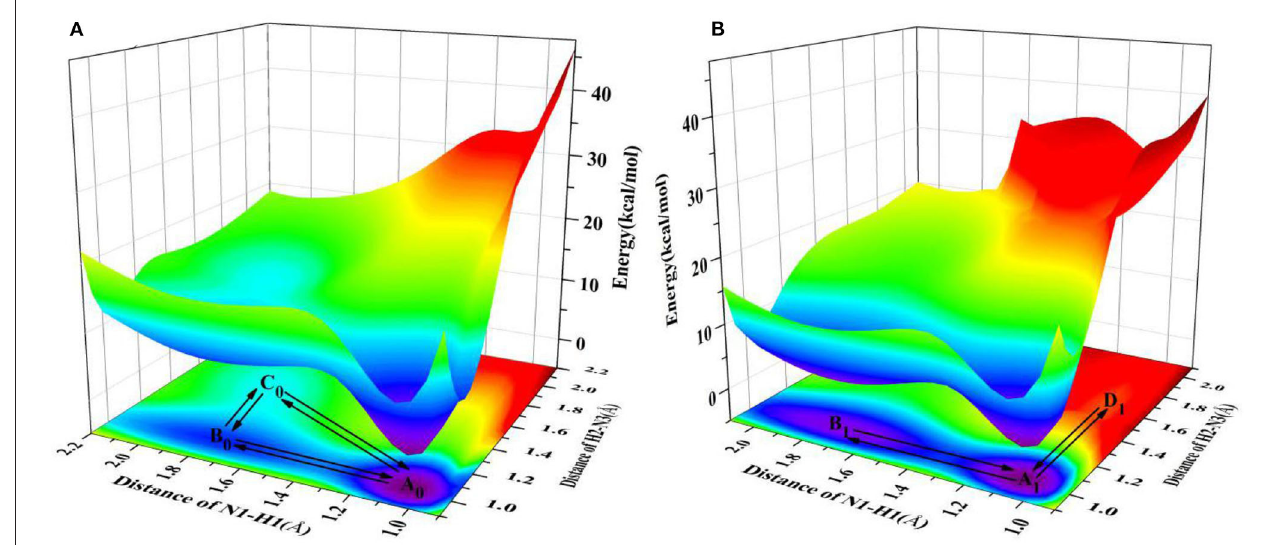
FIGURE 2 | PESs on both S 0 and S 1 states of ZP as the functions of N1-H1 and H2-N3 length in the aqueous phase. (A) S 0 state PES; (B) S 1 state PES.